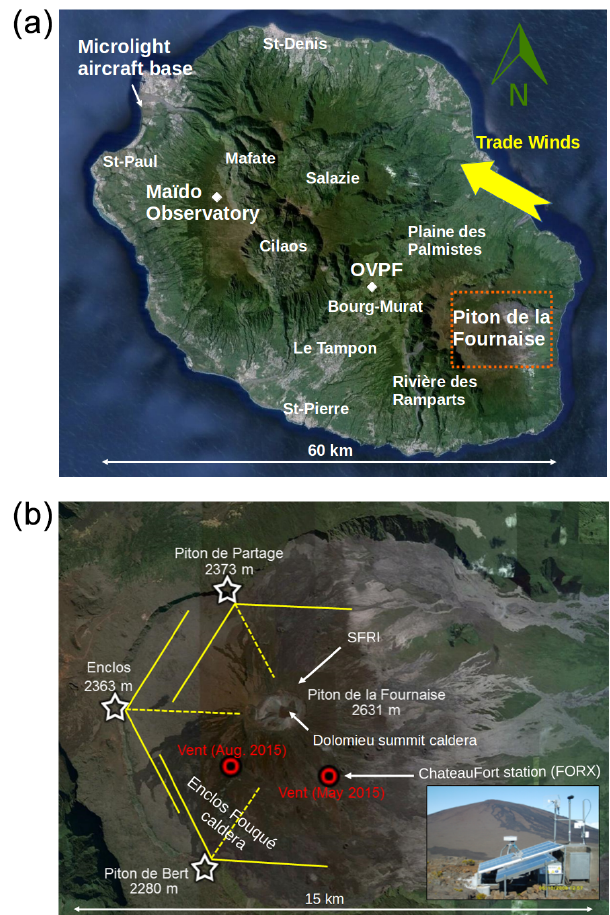
Figure 1. (a) Map of La Réunion island including the sites of inter- est quoted in the text: the locations of the principal cities, the Piton de La Fournaise volcano and the three major sites of the campaign (white). The yellow arrow indicates the mean direction of the trade winds and the dotted rectangle represents the area shown in the bot- tom panel. (b) Location of the scanning-DOAS stations of the NO- VAC/OVPF network (stars; the picture shows the Enclos station). The dashed lines are the azimuths of the main axis for each sta- tion and the continuous lines the angular coverage of each scanner. The locations of the main eruptive vents of the May and August– October 2015 eruptions are also shown (concentric